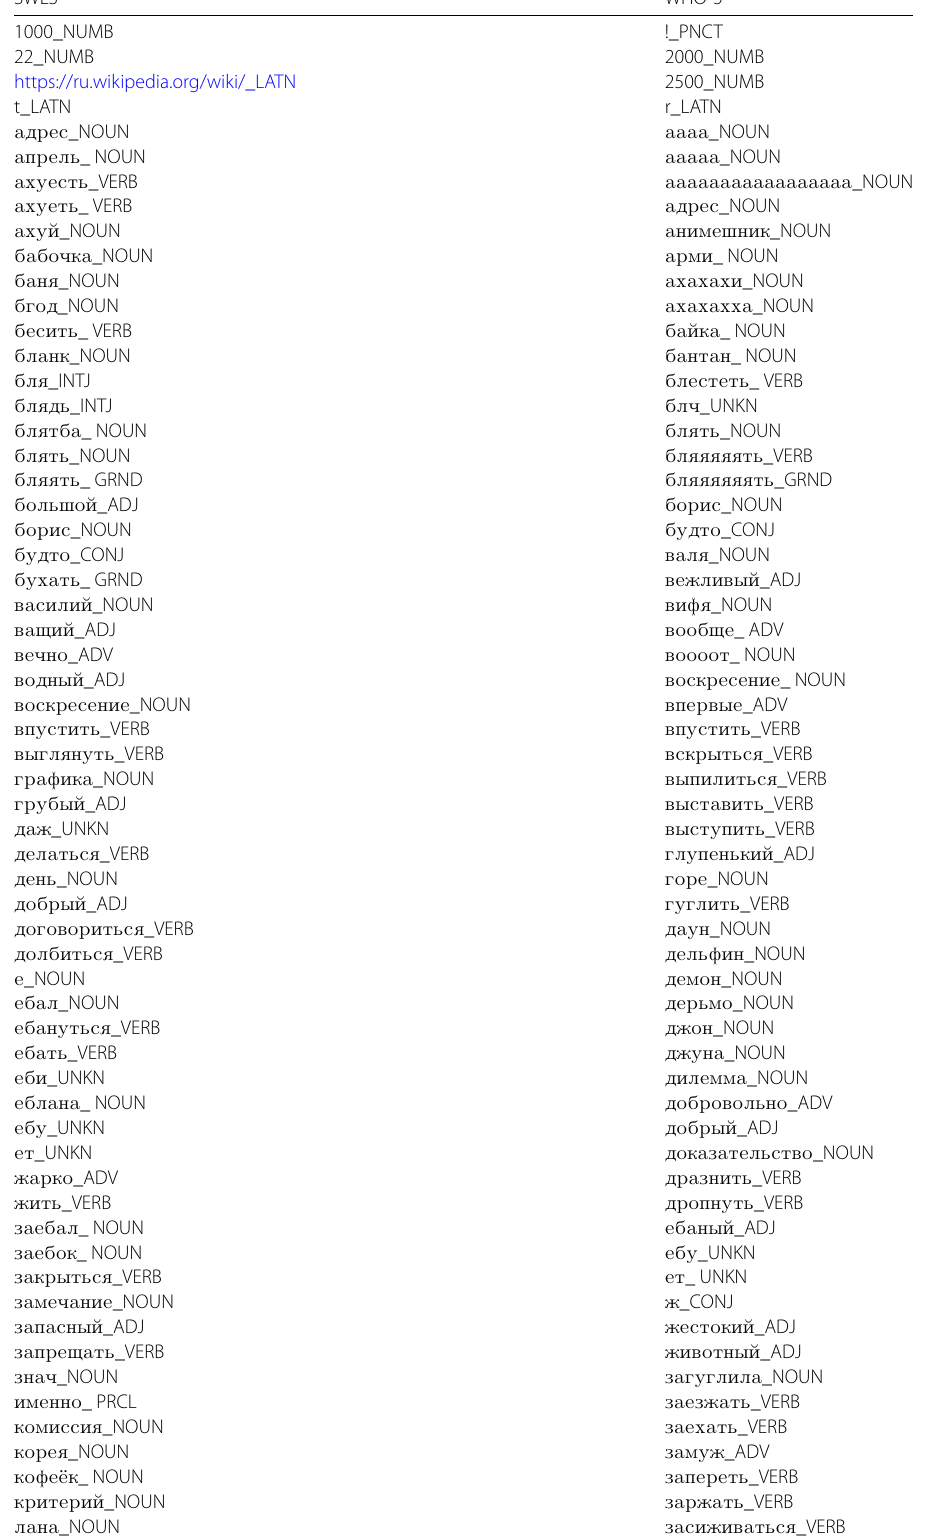
Table 14 Total list of words used as features for the SWLS and WHO-5 prediction SWLS